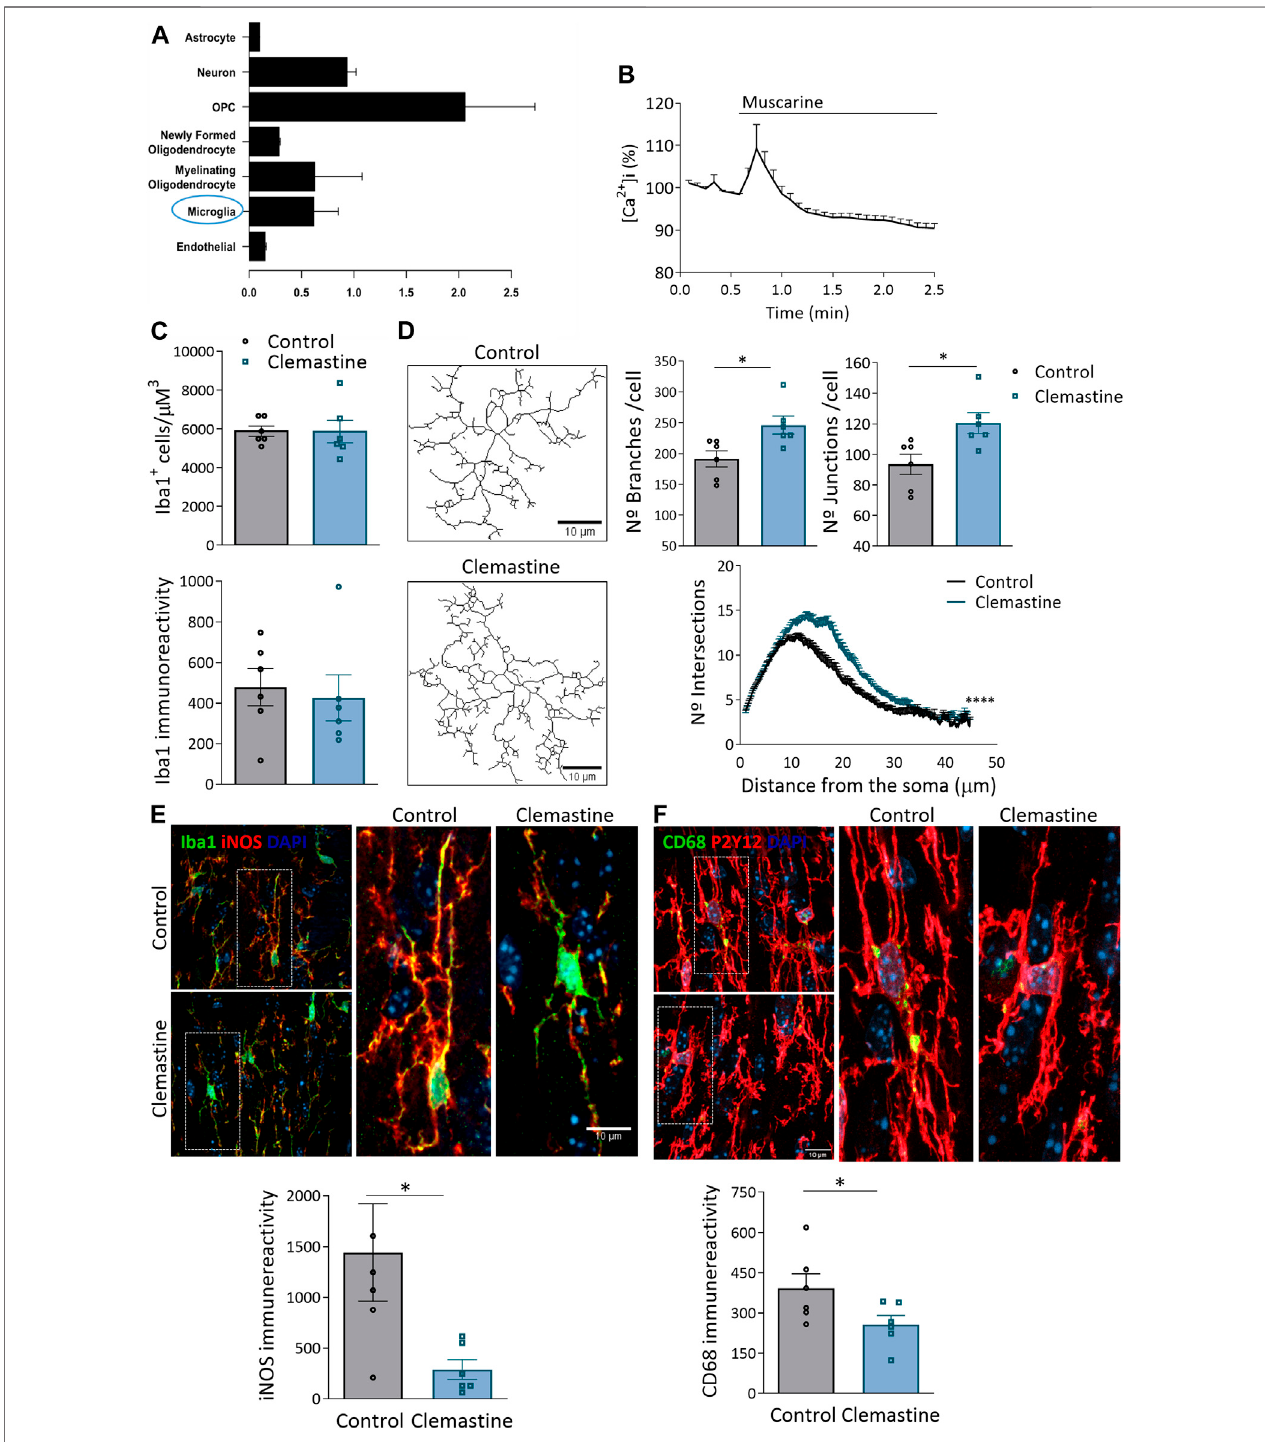
FIGURE5|(A) GraphshowingChmr1genexpressioninallCNScelltypes.NotethatChmr1isalsoexpressedinmicroglia.DatawastakenfromBrainRNA-seqdatabase (Zhang et al., 2014). (B) Recordings of Ca 2+ responses in microglia in vitro following application ofmuscarine(100 μ M; arrow)usingFluo-4. Data representaverage ±s.e.m. of valuesobtainedfrommorethan50cellsfrom3differentcultures. (C) Quanti fi cationofthenumberofIba1+microgliacellsaswellasIba1stainingintensityin corpuscallosum of control and clemastine-treatedmice. (D) Representative skeletonizedimagesofmicroglia usedformorphologicalanalysis.Scale bar = 10 μ m. Graphs show averageof the number of branches, junctions and sholl analysis of microglia in control and clemastine-treted mice. (E) Representative compressed z confocal images showing the expression of iNOS, a pro-in fl ammatory marker, and CD68, a phagocytic marker, in Iba1 + microglia in corpus callosum of control and clemastine-treated mice. Scale bar = 10 μ m. Graphs show the average P2y12 and CD68 staining intensity ( n = 6 mice per group). * p < 0.05, ** p < 0.01.